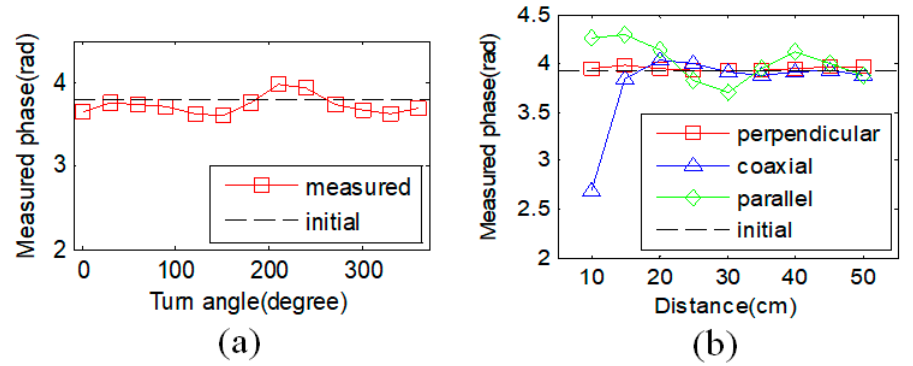
Figure 4. The measured phase of ( a ) different turn angles and ( b ) different distances.